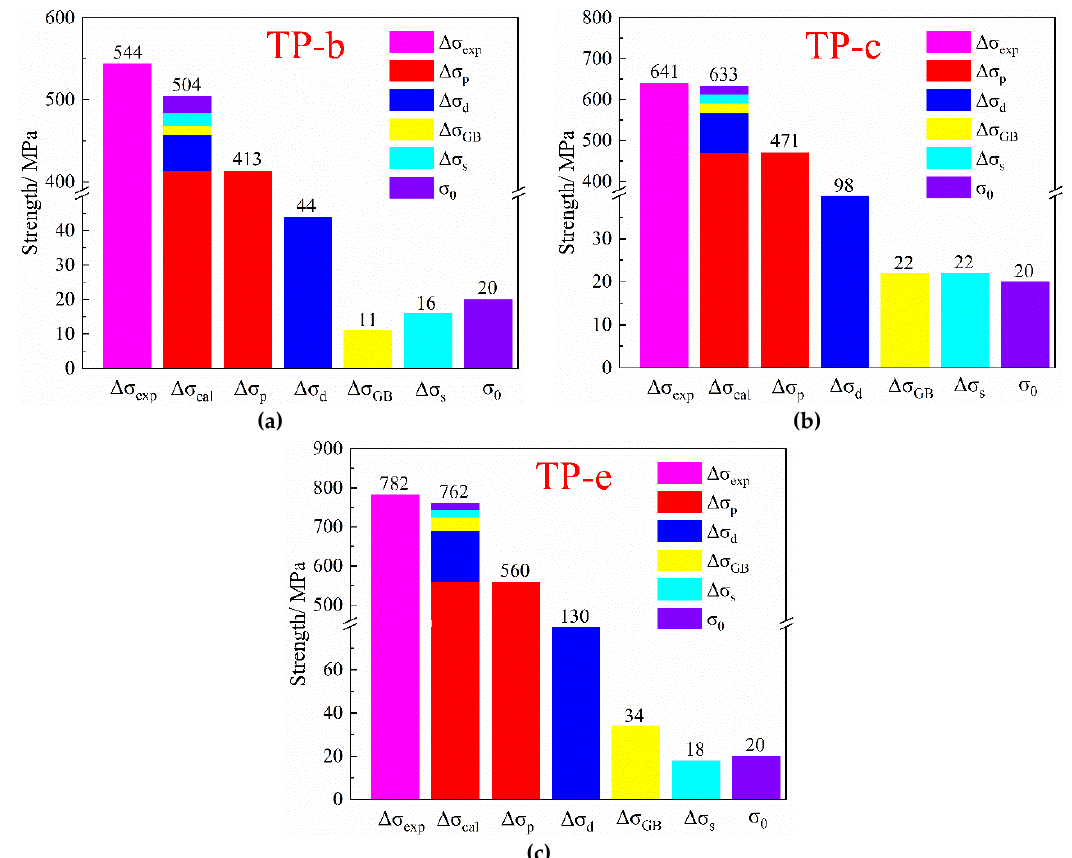
Figure 15. Comparison between experimental and calculated yield strengths with different heat treatments. The combined heat treatments of ( a ) TP ‐ b, ( b ) TP ‐ c and ( c ) TP ‐ e.